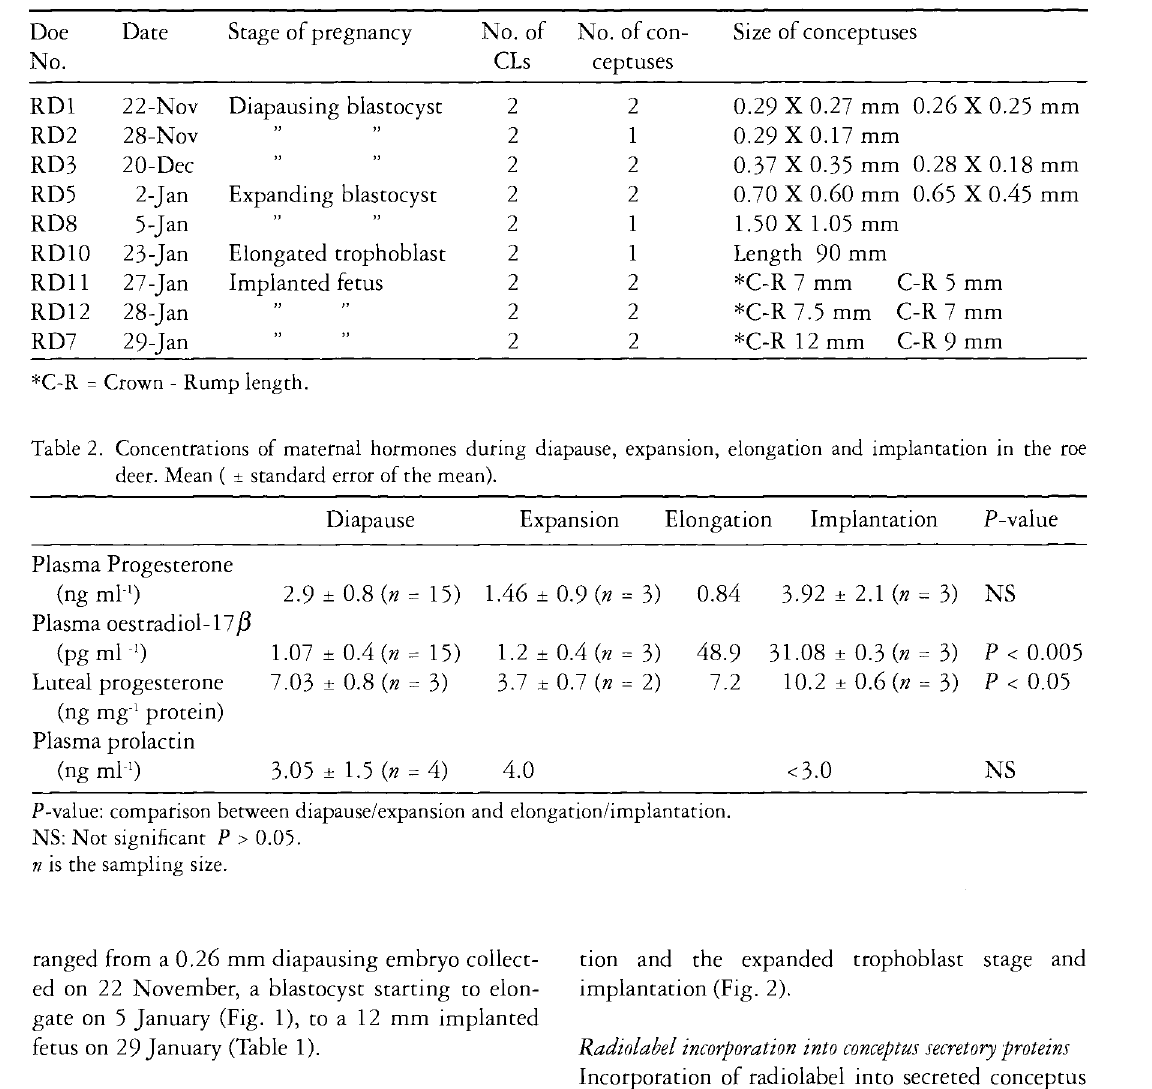
Table 1. Date of collection, number of corpora lutea (CL), and number and size of conceptuses of pregnant roe deer. Doe Date